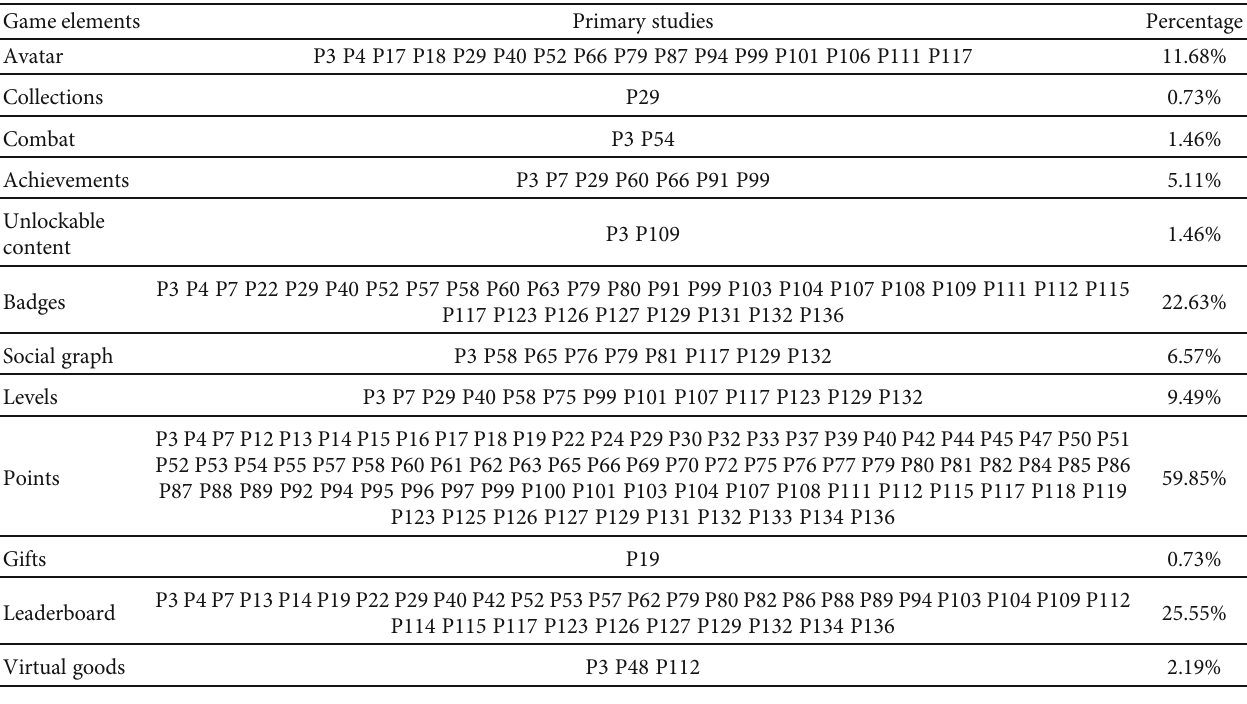
Table 12: Game elements per primary studies.